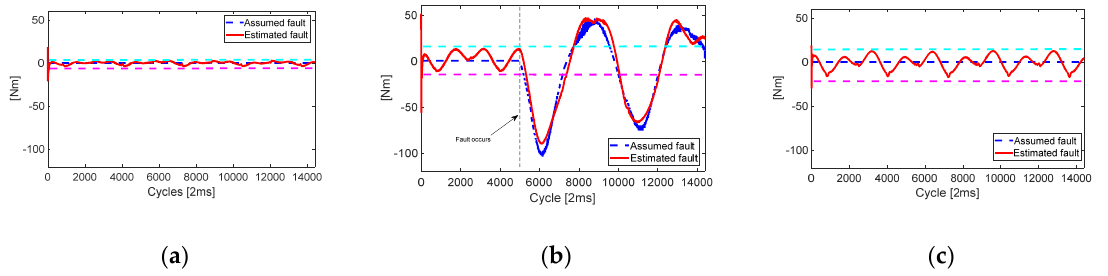
Figure 10. Fault estimation results with a single joint fault occurring at Joint 2. The aqua and pink dashed lines are the upper and lower thresholds, respectively. ( a ) Joint 1; ( b ) Joint 2; ( c ) Joint 3.